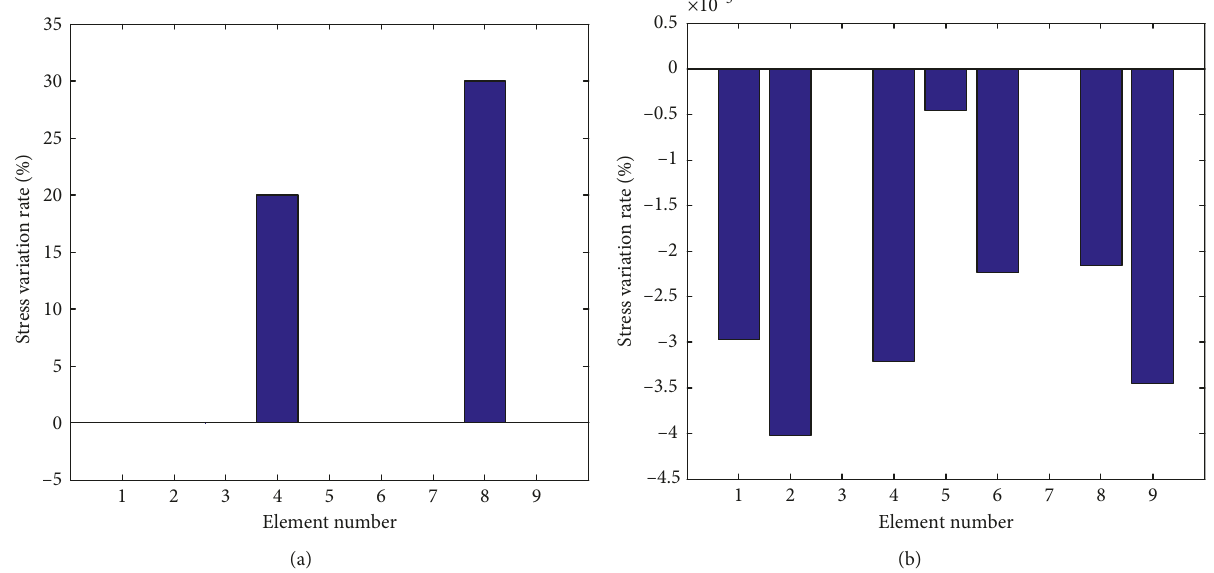
Figure 4: Stress variation rate of the truss model: (a) complete measurement data; (b) incomplete measurement data.